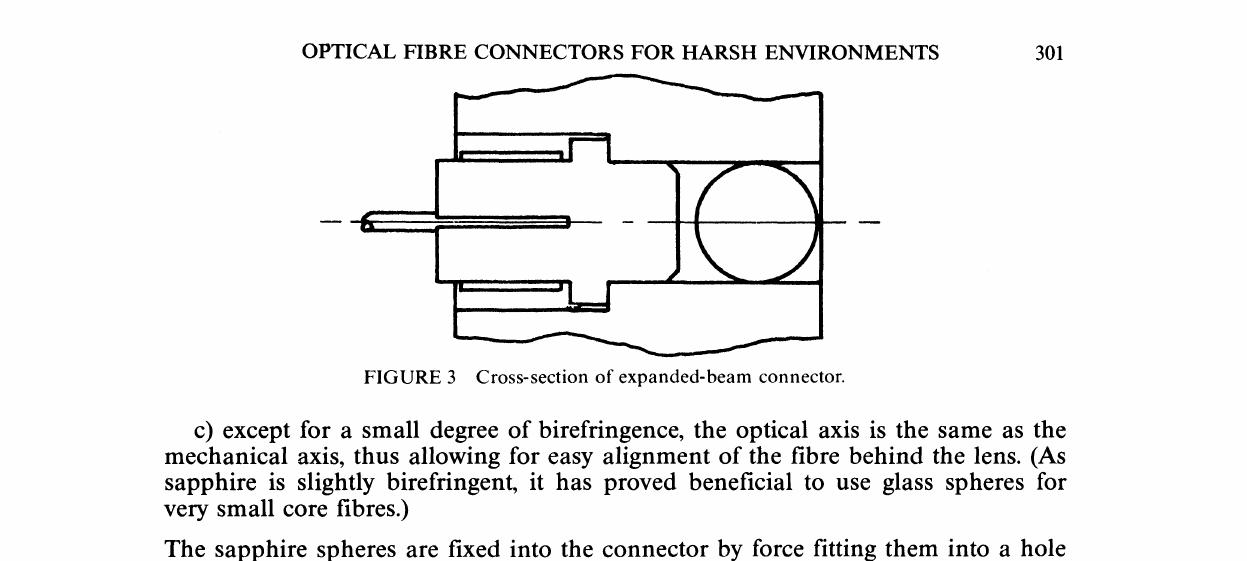
FIGURE 3 Cross-section of expanded-beam connector.